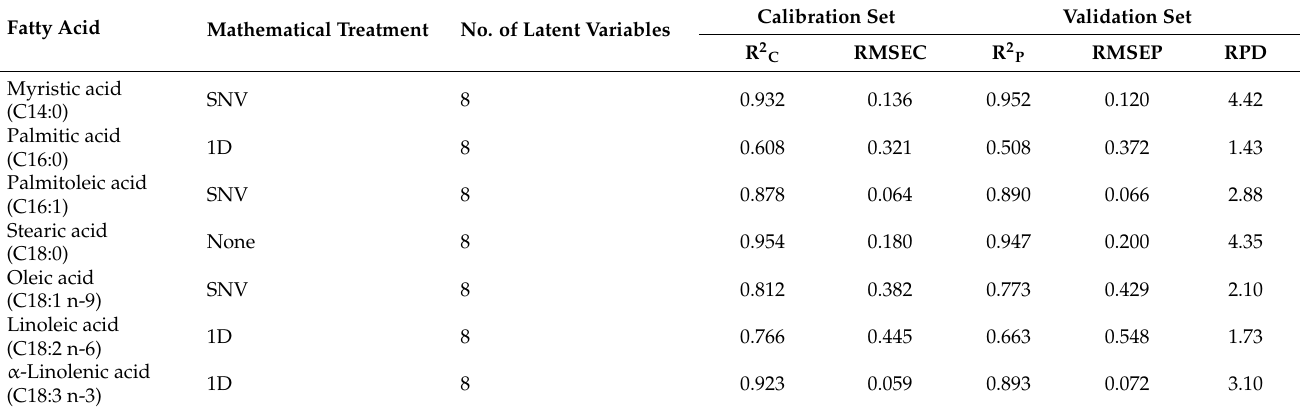
Table 5 outlines NIR prediction models for the fatty acid content in Tenebrio molitor larvae in the calibration and validation sets, which was based on the NIR raw spectra using different mathematical treatments. As primary pretreatments for the fatty acid spectral data, standard normal variate (SNV) and the first derivative (1D) were considered as suitable. Optimal combination of algorithm parameters was established on the basis of standard error of cross-validation of PLS calibrations. The best results were obtained with standard normal variate for myristic acid, palmitoleic acid and oleic acid. Palmitic acid, linoleic acid and α -linolenic acid required a first-order derivation, while stearic acid needed no mathematical pretreatment to get the best results. Table 5. Statistics of NIR prediction models for fatty acid content in living mealworm